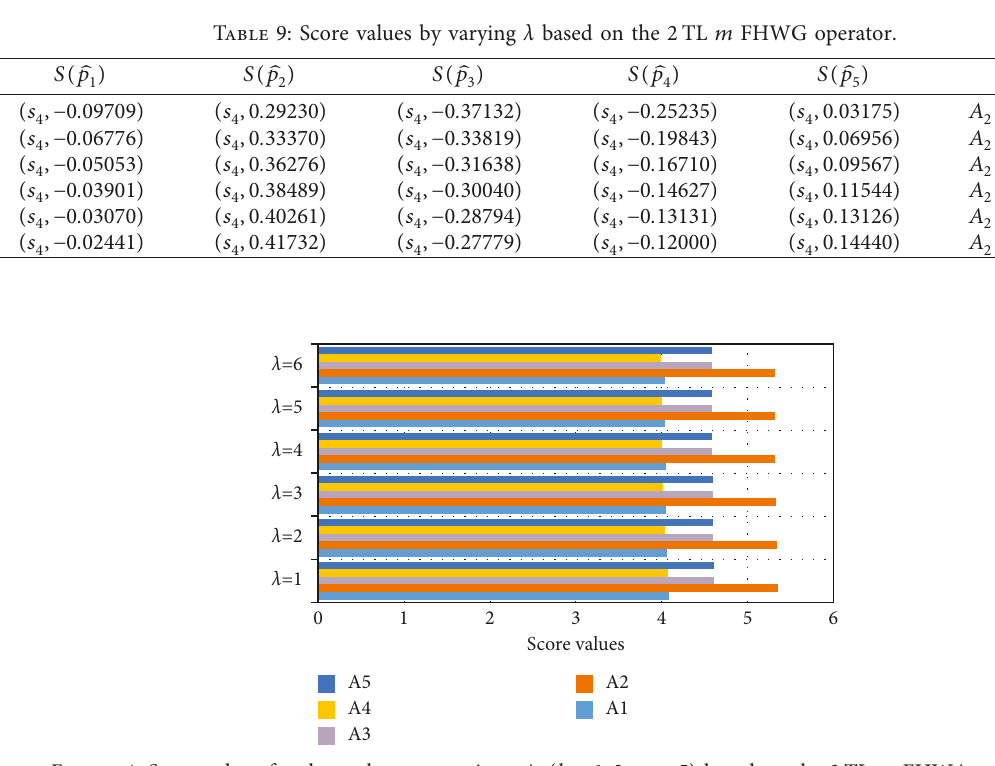
k 1 , 2 , ... , 5 based on the 2TL m FHWA operator. k ( (cid:26) )